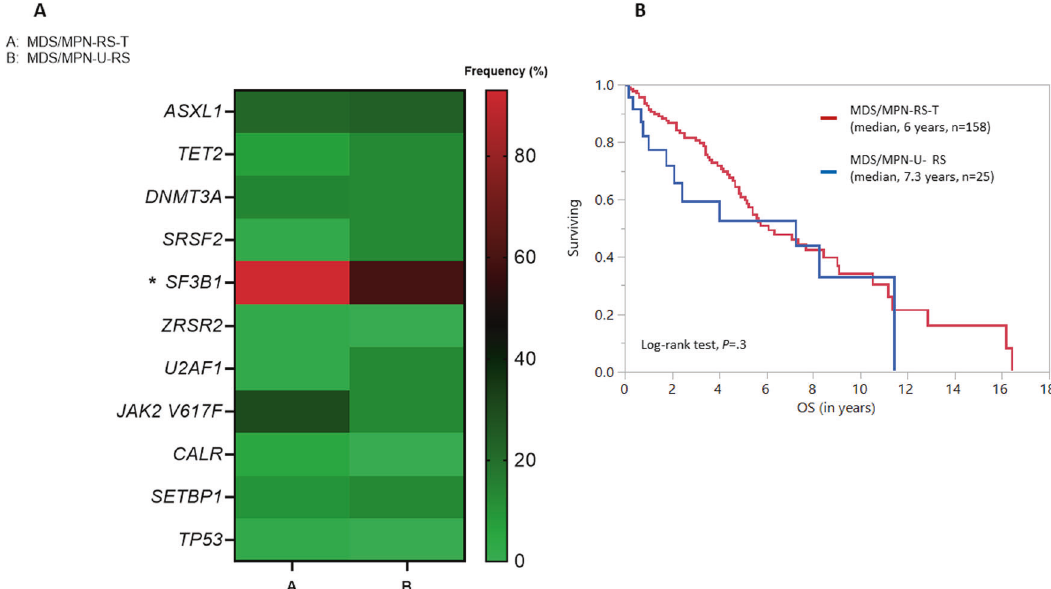
Fig. 3 Figure showing molecular landscape, OS and LFS differences between WHO-de fi ned MDS/MPN-RS-T and MDS/MPN-U patients with BM RS ≥ 15% (MDS/MPN-U-RS). A shows a heatmap displaying differences in mutational frequencies between MDS/MPN-RS-T and MDS/ MPN-U-RS. SF3B1 is the only gene mutated at a signi fi cantly (*) higher frequency in the MDS/MPN-RS-T group. B shows that the Kaplan – Meier estimate of median OS (95% CI) did not differ signi fi cantly between the two groups [6 (5 – 9) versus 7.3 (1.8 – 11.4) years, P = 0.3]. Log-rank test was used to calculate the P